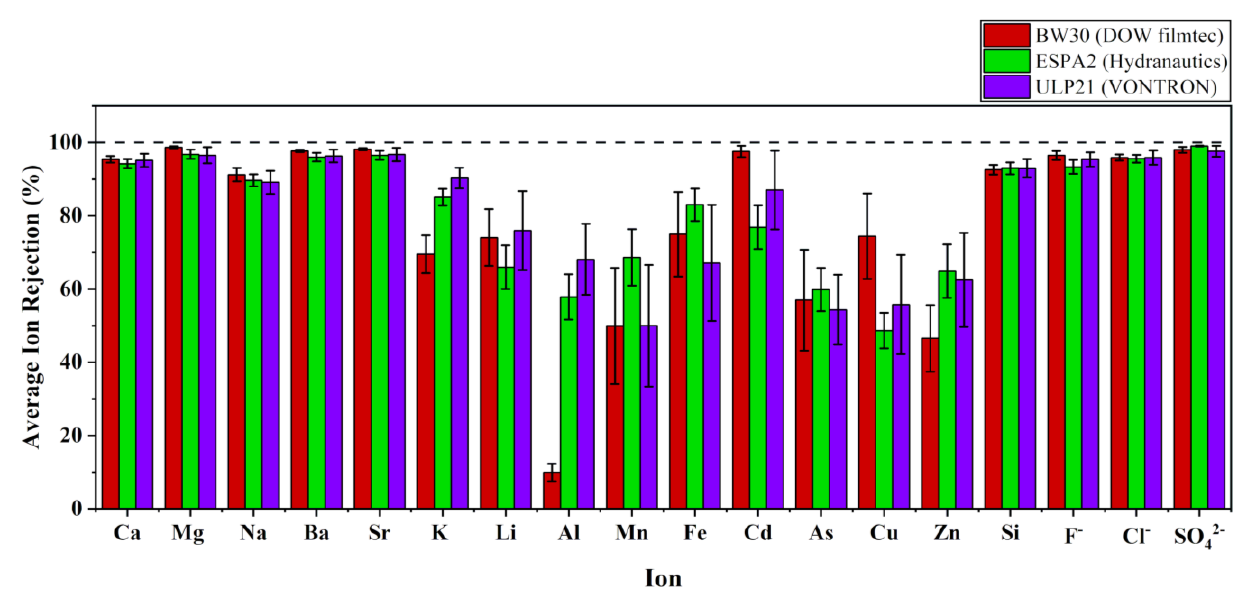
Figure 5. Average rejection of individual ions by three types of RO membranes.